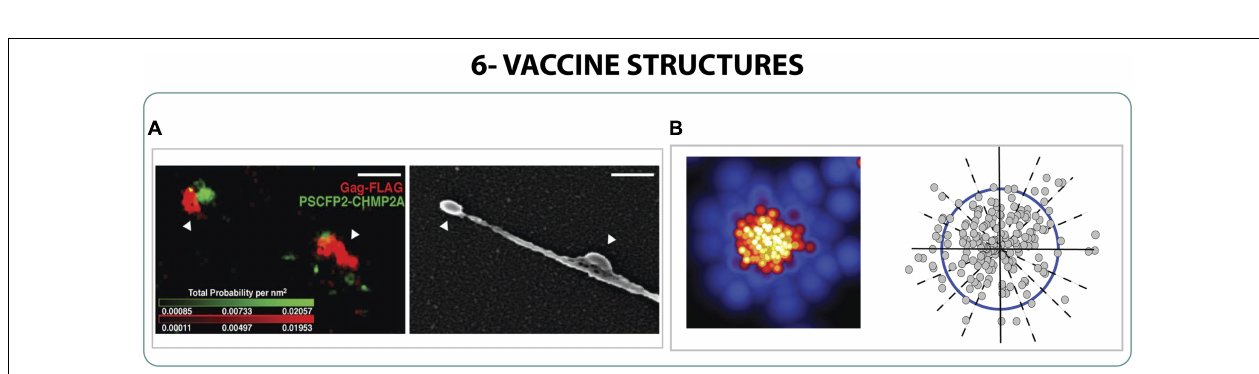
FIGURE 6 | Cell to cell transfer. EM (left) and 2-color 3D STORM (middle) of CD81 (green) and PB1 (red) on filaments of Influenza. Scale bar 500 nm (He et al., 2013).